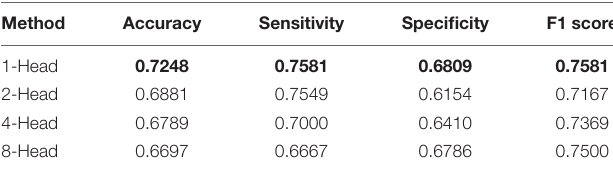
TABLE 2 | Comparison of the classification performances between the different number of heads in the self-attention layer.